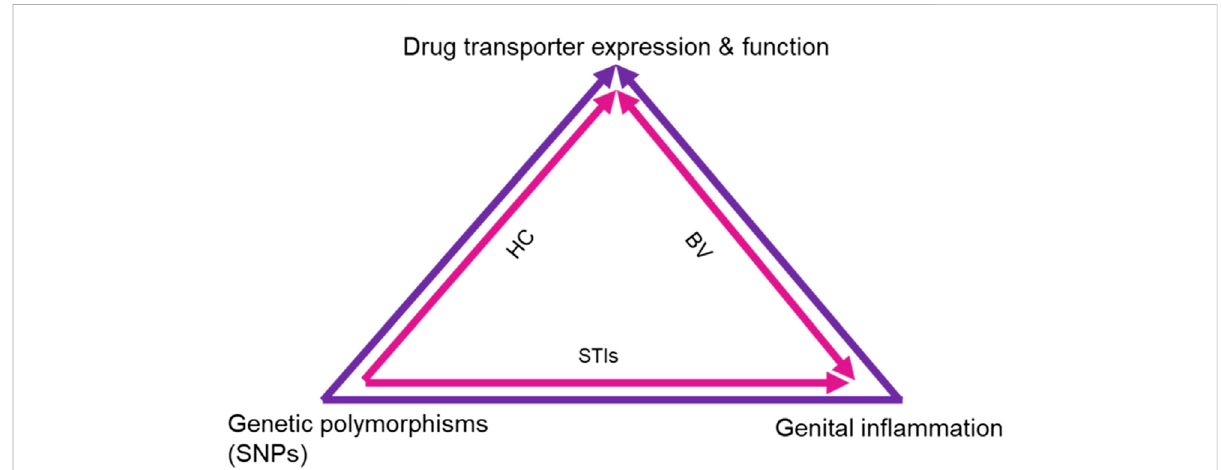
FIGURE 2 Proposed mechanism of effects on drug transporter expression and function. The schematic shows the intersection of different biological factors and SNPs in drug transporter genes that affect drug transporter expression in the FGT, renal system and blood, subsequently affecting PrEP ef fi cacy. Genital in fl ammation and SNPs are known to directly affect drug transporter expression and functionality, while the combined use of HCs and ARVs also affects drug transporter expression and function. Additionally, the presence of STIs and BV are shown to contribute to genital in fl ammation which in turn affects drug transporter expression and function. HC, Hormonal contraceptives; BV, Bacterial vaginosis; STIs, Sexually transmitted